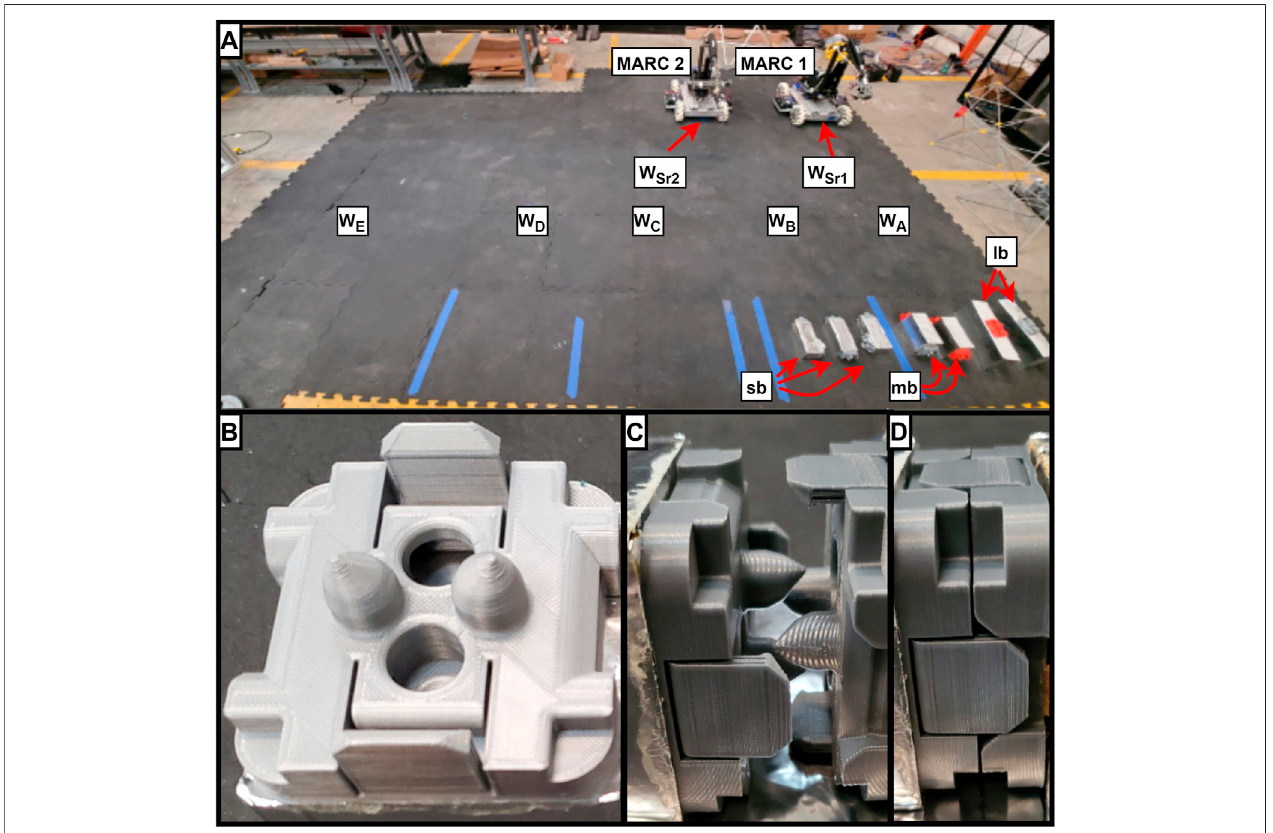
FIGURE 2 | (A) Arch assembly workspace with location, component, and robot labels, (B) One side of the androgynous connector, (C) Both sides of the androgynous connector about to be connected, (D) Androgynous connector in the connected state.